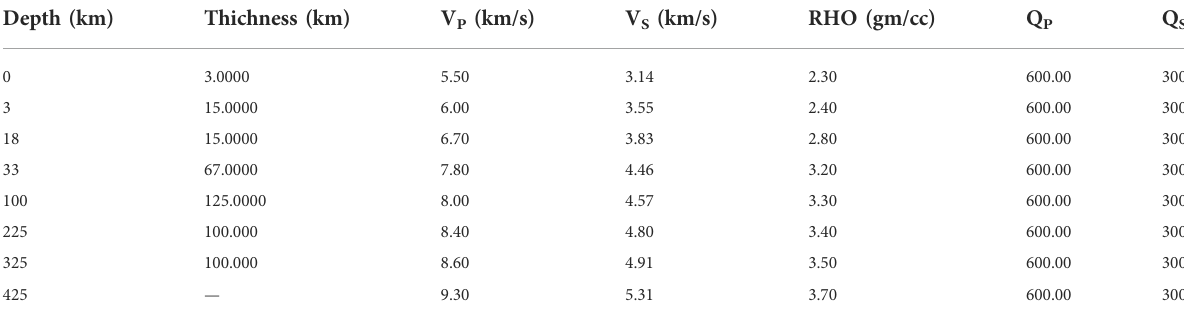
TABLE 2 Velocity structure for the used Green Function (Kubo et al., 2002). Depth